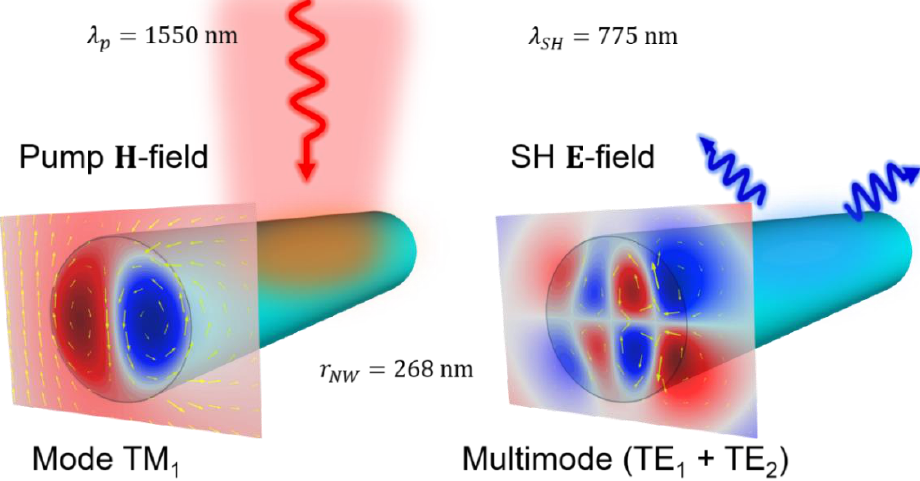
Figure 6. Pump and SH field distribution for a GaAs nanowire with radius 268 nm illuminated with TM-polarized pump source tuned at 1550 nm.